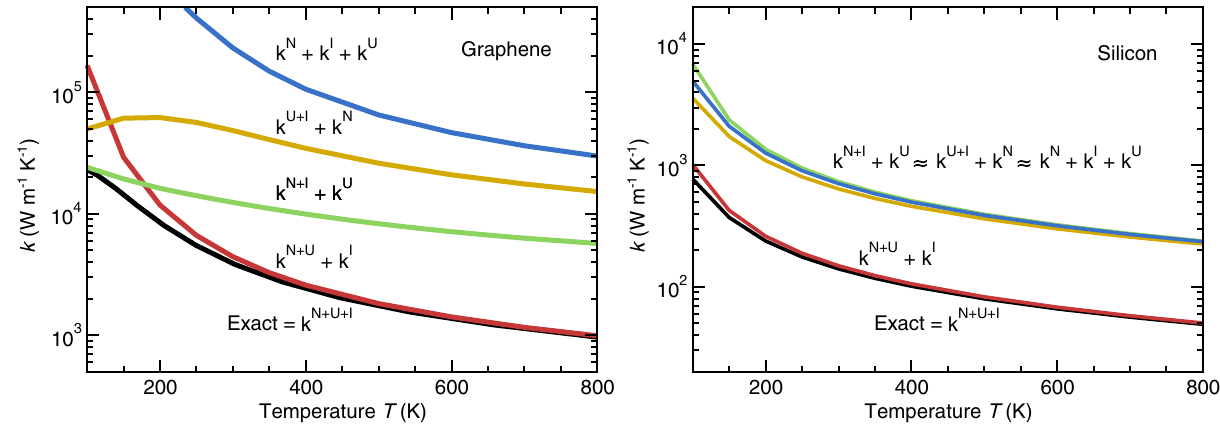
FIG. 9. Study of the failure of the Matthiessen rule in graphene and silicon. The total thermal conductivity (black line) is compared to conductivities computed through various Matthiessen sums, where the total sum is given by the sum of the reciprocals (by k N þ k U þ k I , we mean k − 1 ¼ ð k N Þ − 1 þ ð k U Þ − 1 þ ð k I Þ − 1 ). Because of the correlation between scattering events, there is no decomposition for which the Matthiessen rule is obeyed at all temperatures. The only curve that approaches the exact thermal conductivity is the decomposition ( k N þ U þ k I ), just when the effect of isotopic scattering is